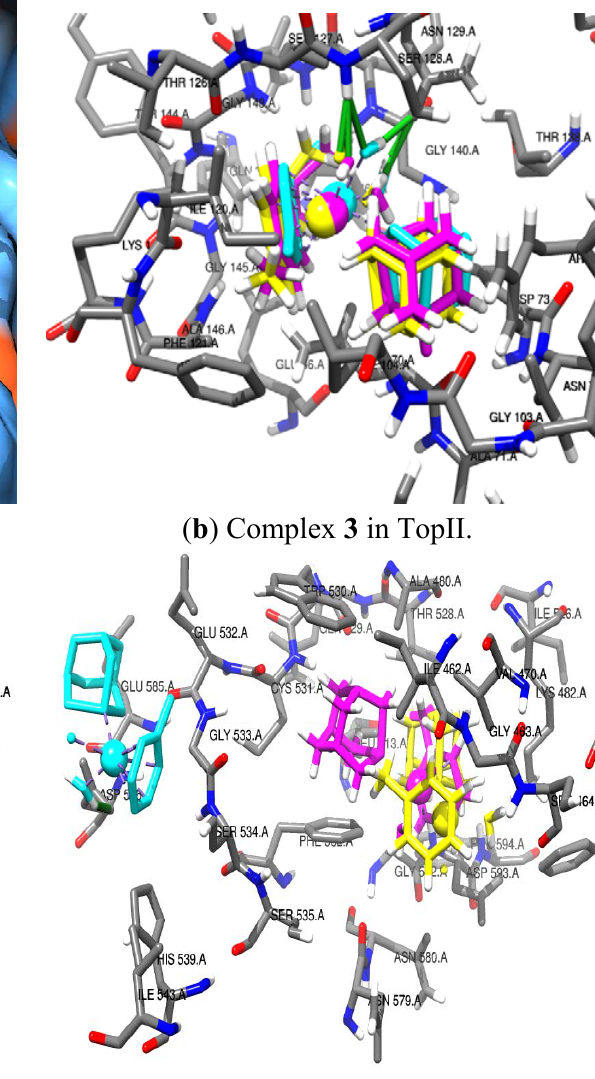
( c ) Complex 4 in gyrase. ( d ) Complex 20 in